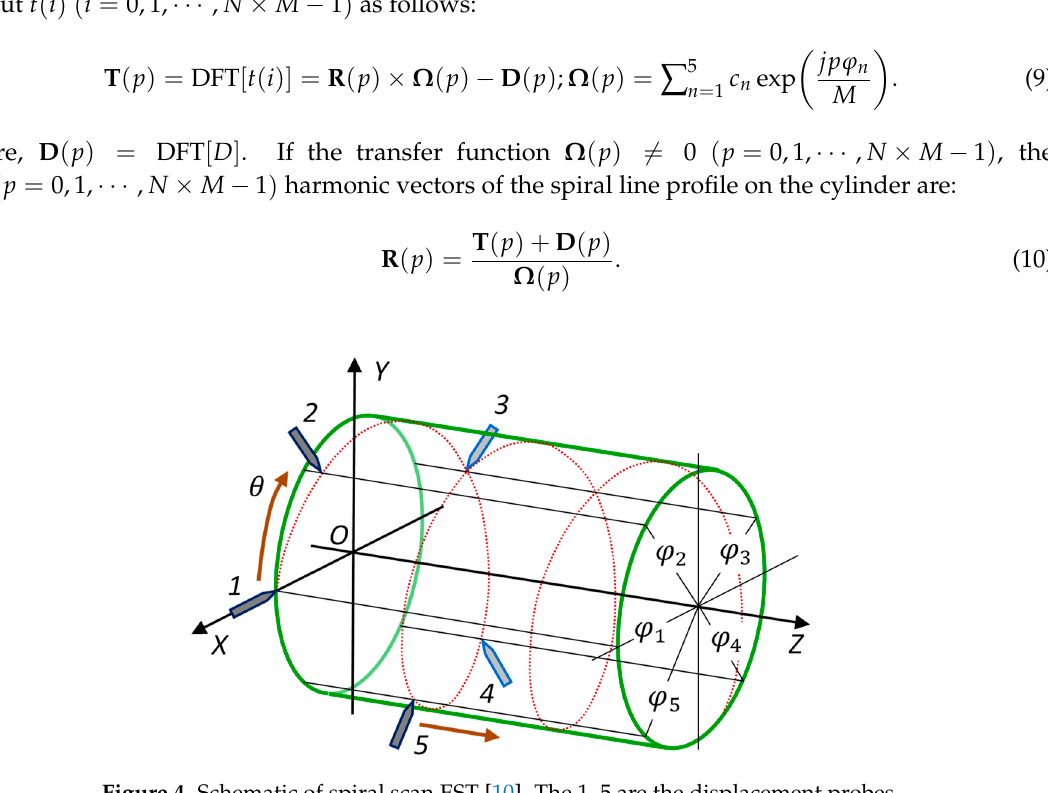
Figure 4. Schematic of spiral scan EST [10]. The 1–5 are the displacement probes.